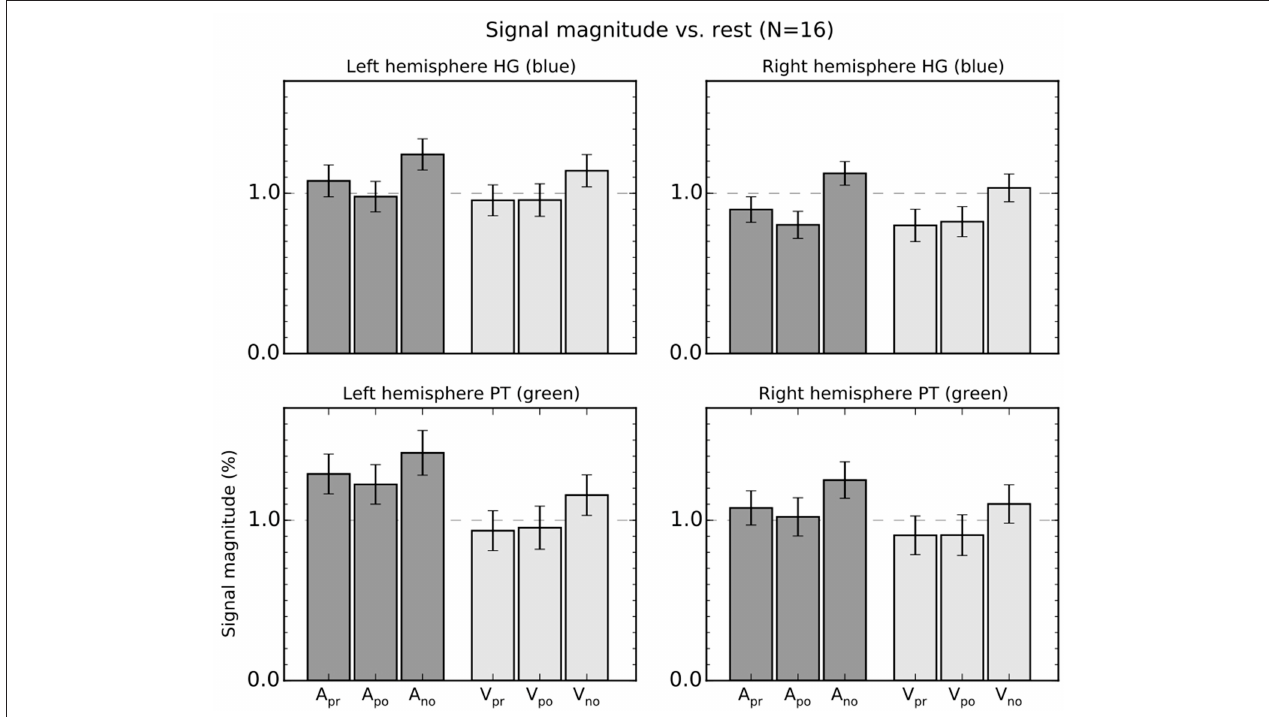
FIGURE 3 | Percentage signal magnitude in the left and right hemisphere planum temporale (PT) and Heschl’s gyrus (HG) ROIs. The bars show mean ( ± SEM) ROI signal relative to rest. The colors in panel titles refer to ROIs shown in Figure 2C